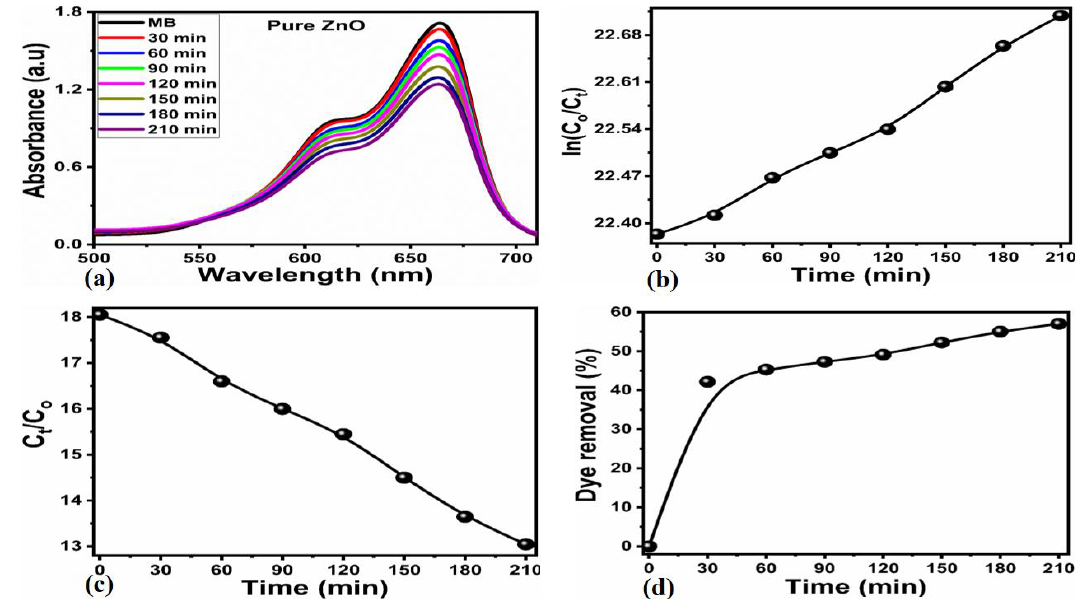
Figure 5. ( a ) UV-visible absorption spectra of 8.22 × 10 −5 M) MB solution using photocatalyst dose of 15 mg of pure ZnO for the time interval of 210 min under the irradiation of natural sunlight, ( b ) Linear plot of ln( C t / C o ) against corresponding time of 210 min. ( c ) Linear plot of C t / C o . ( d ) Degradation efficiency of MB solution.